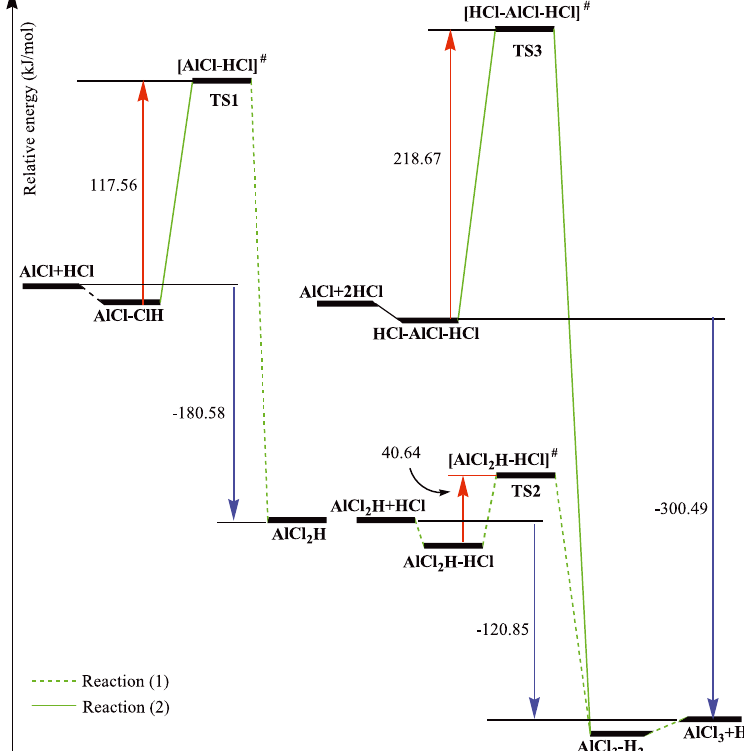
Figure 6. Potential energy surface, reaction energies (kJ mol -1 ) and activation barrier energies (kJ mol -1 ) for reaction between AlCl and